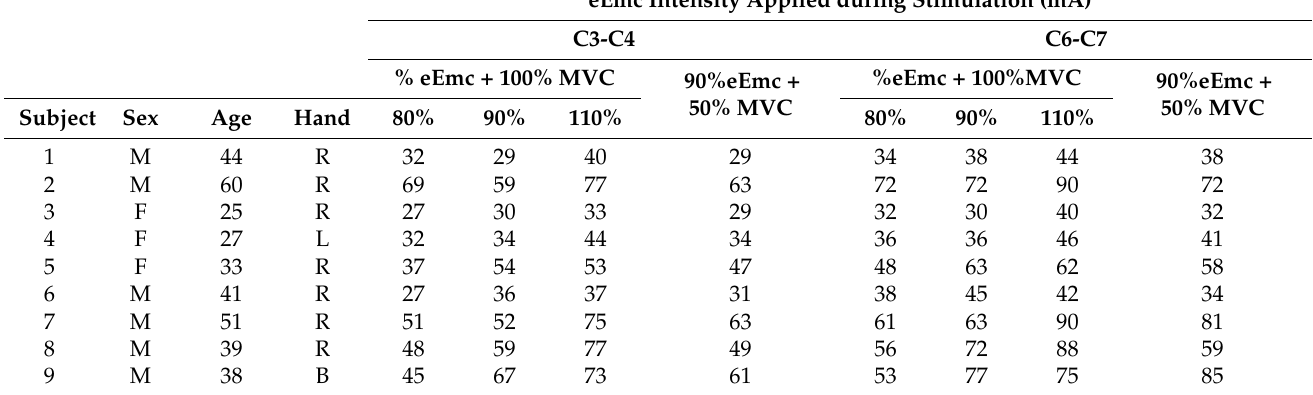
Table 1. Demographic data of healthy individuals and current intensities used for cervical stimulation at C3-C4 and at C6-C7 level.